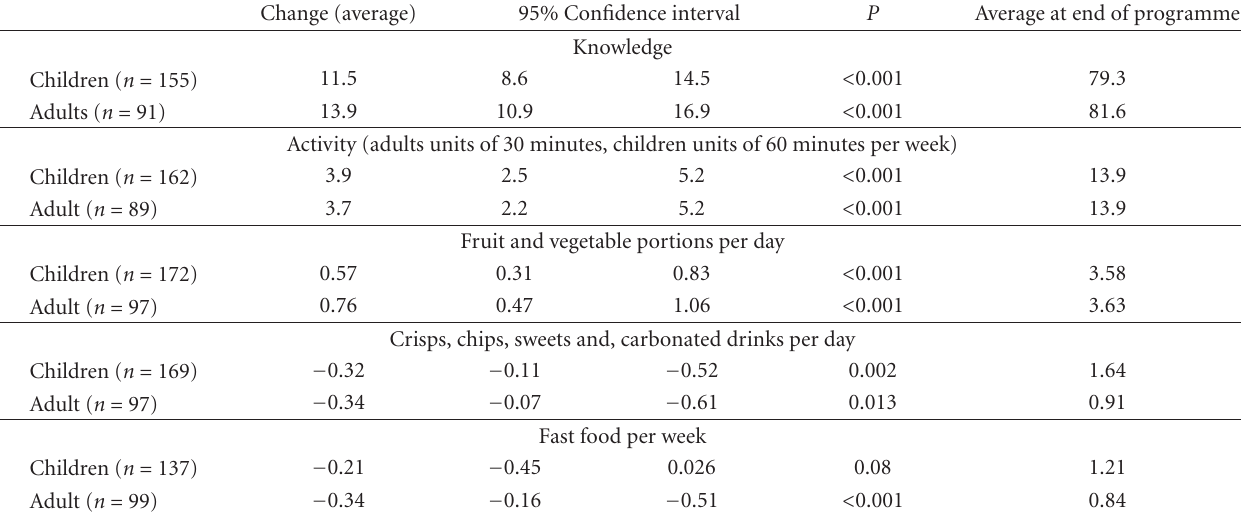
Table 3: Summary of behaviour change among the 293 OBOL participants (107 adults and 186 children) for whom baseline and outcome data was available.